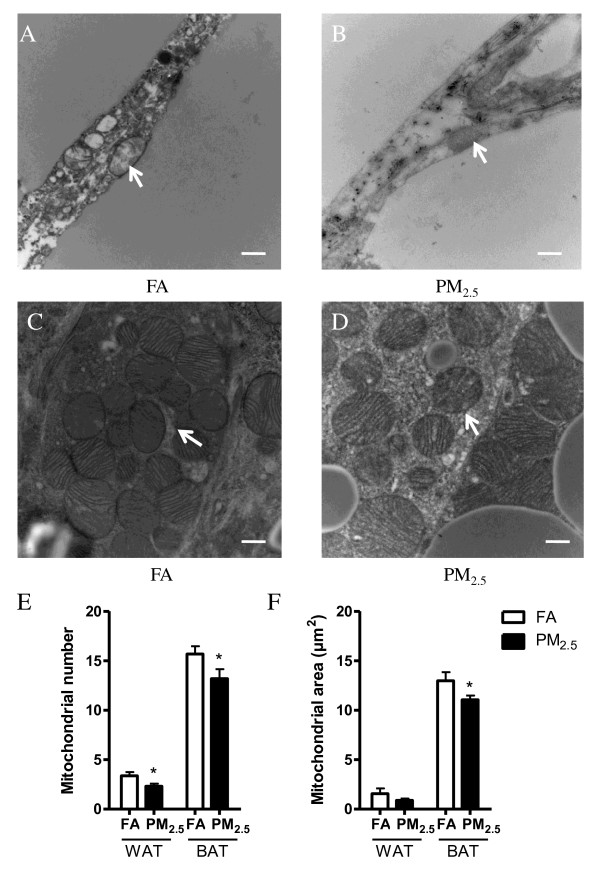
The number and area of mitochondria in the eWAT and iBAT. A-B. Representative TEM images of eWAT. C-D. Representative TEM images of iBAT (Arrows point to mitochondria). E: The analysis of mitochondrial number per field in the eWAT and iBAT. F: The analysis of mitochondrial area per field in the eWAT and iBAT. n = 4. *P < 0.05 vs. FA. Scale bars represent 500 nm in panels A, B, C and D.